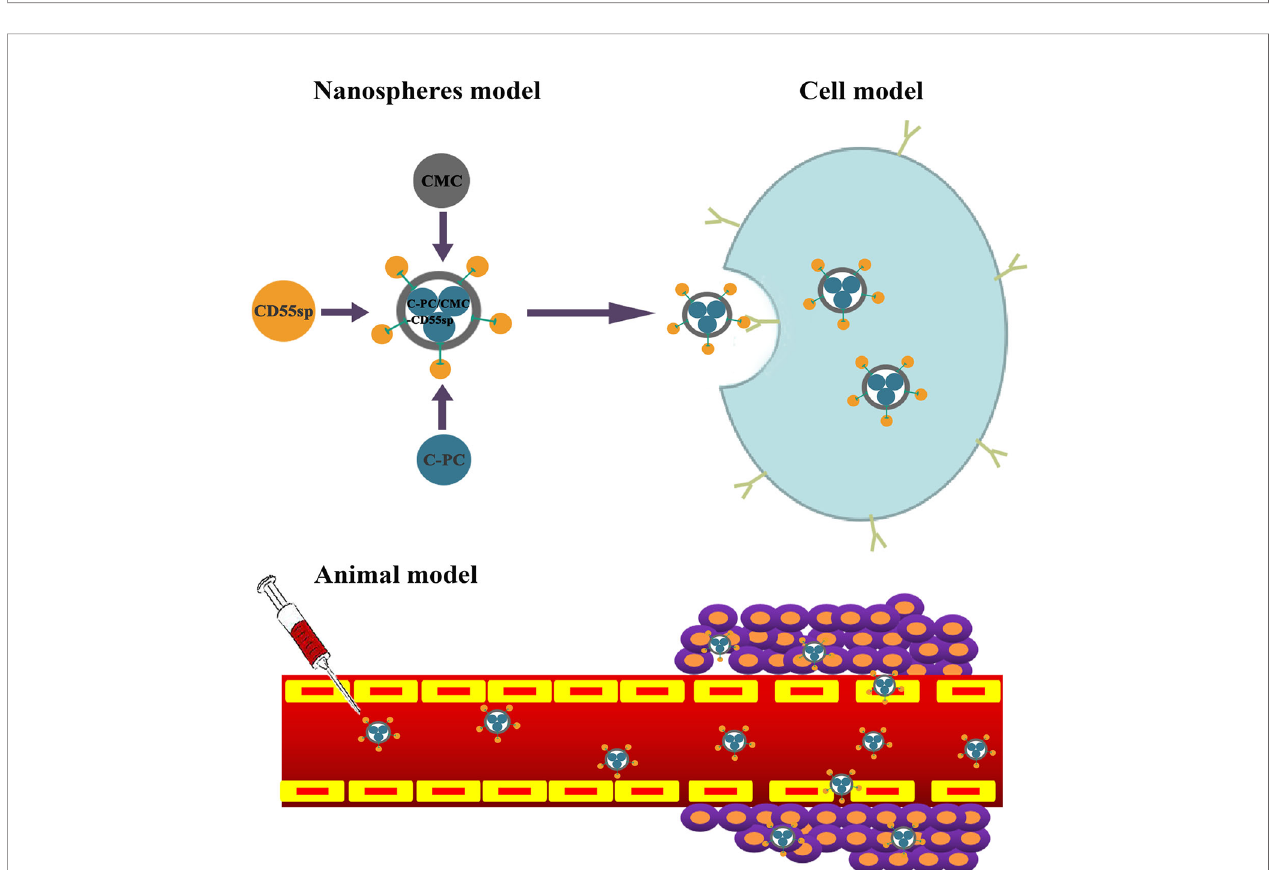
FIGURE 7 | A model for C-PC/CMC-CD55sp nanospheres in targeting tumor cells in vivo and in intro